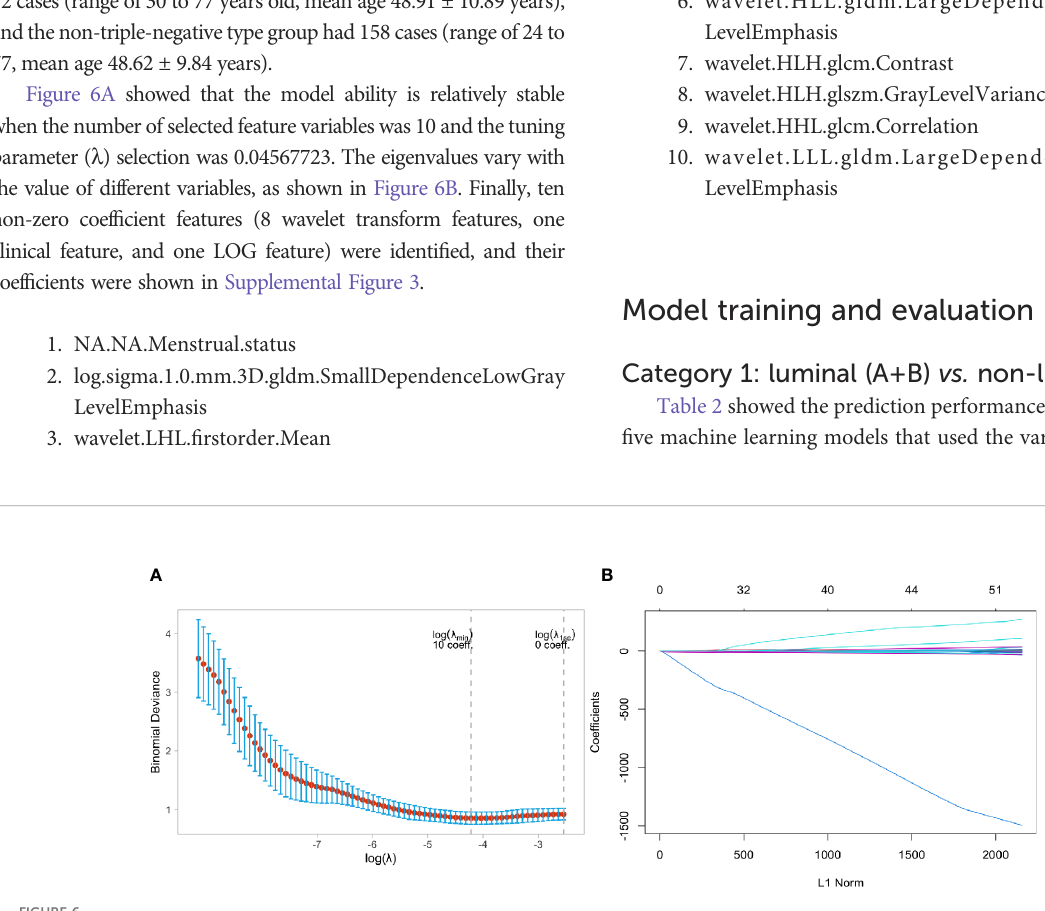
FIGURE 6 Feature selection using the least absolute shrinkage and selection operator (LASSO) binary logistic regression model in Triple negative and Non- Triple negative group. (A) Tuning parameter selection in the LASSO model used 5-fold cross-validation via minimum criteria, (B) LASSO coef fi cient pro fi les of the baseline